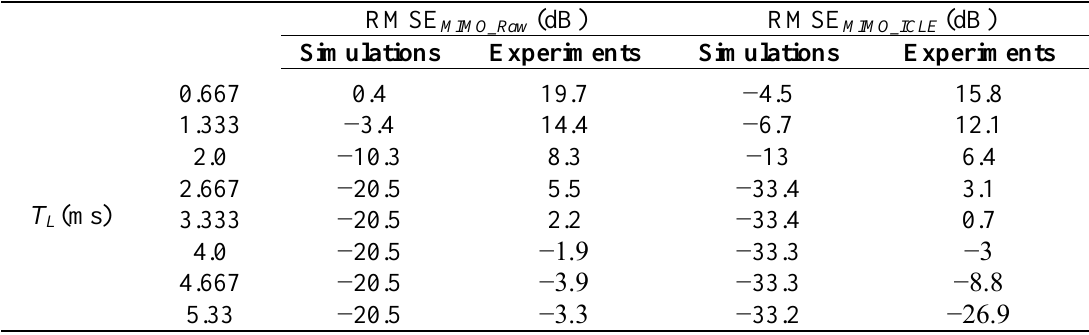
as functions of T . L MIMO_ICLE